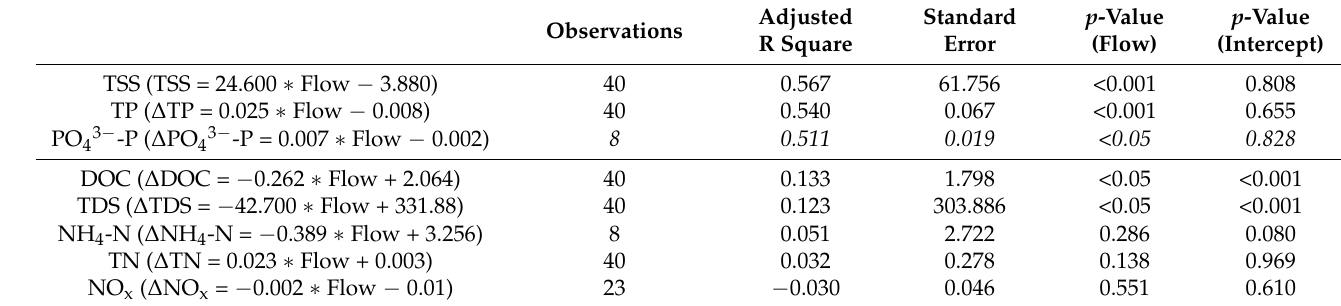
Table 2. Regression models of the net change in concentration values for constituents travelling along the Upper Qu’Appelle River, as a function of flow at the upstream Elbow Diversion gauging station. Constituents are total suspended solids (TSS), total phosphorus (TP), orthophosphate (PO 43 − -P), dissolved organic carbon (DOC), total dissolved solids (TDS), ammonium (NH 4 -N), total nitrogen (TN) and nitrate-nitrite (NOx). Flow is average daily flow in m 3 /s and constituents are in mg/L.